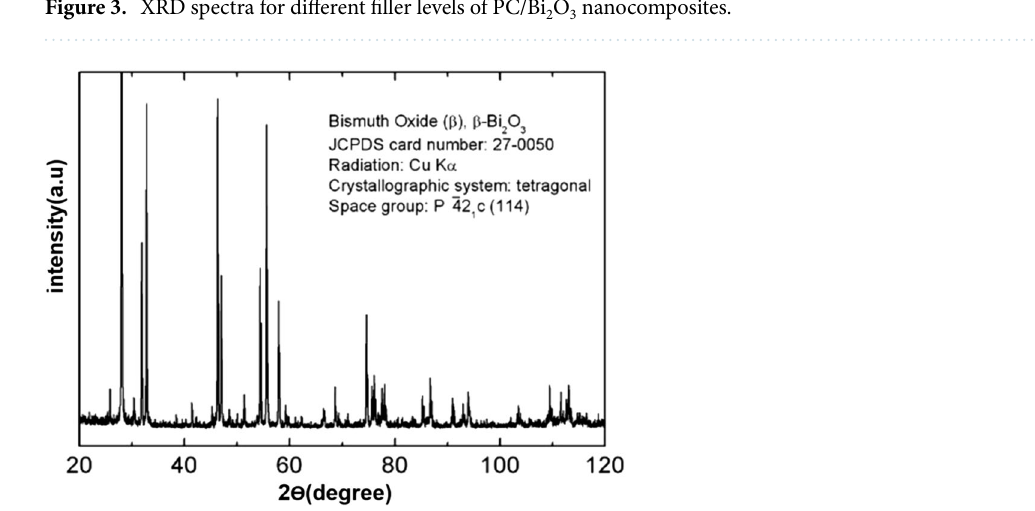
Figure 3. XRD spectra for different filler levels of PC/Bi 2 O 3 nanocomposites.